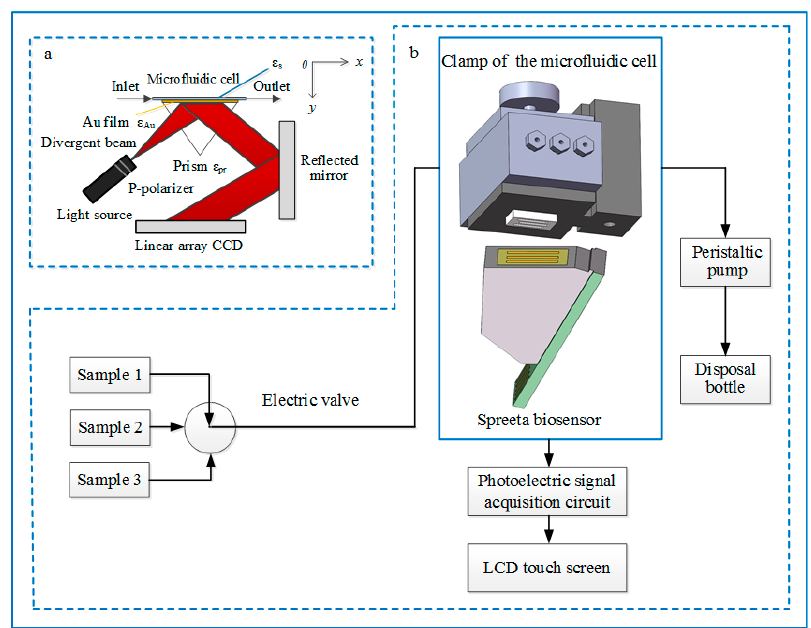
Figure 1. The schematic diagram of the portable surface plasmon resonance (SPR) bioanalyzer. ( a ): Principle of surface plasmon resonance biosensing platform; ( b ): Schematic representation of construction of the portable SPR bioanalyzer.